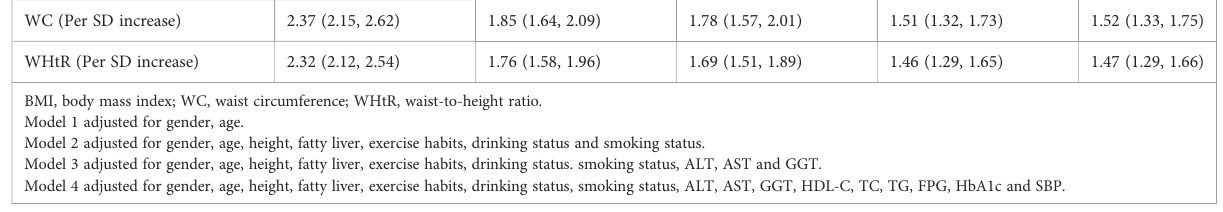
BMI, body mass index; WC, waist circumference; WHtR, waist-to-height ratio. Model 1 adjusted for gender, age. Model 2 adjusted for gender, age, height, fatty liver, exercise habits, drinking status and smoking status. Model 3 adjusted for gender, age, height, fatty liver, exercise habits, drinking status. smoking status, ALT, AST and GGT. Model 4 adjusted for gender, age, height, fatty liver, exercise habits, drinking status, smoking status, ALT, AST, GGT, HDL-C, TC, TG, FPG, HbA1c and